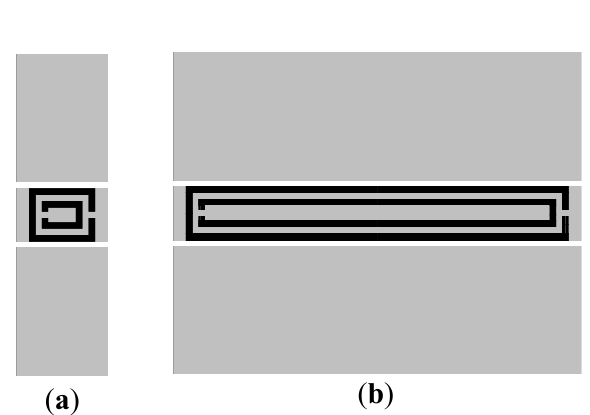
= 2.07 mm ( a ), L = 12.4 mm ( b ), 1 1